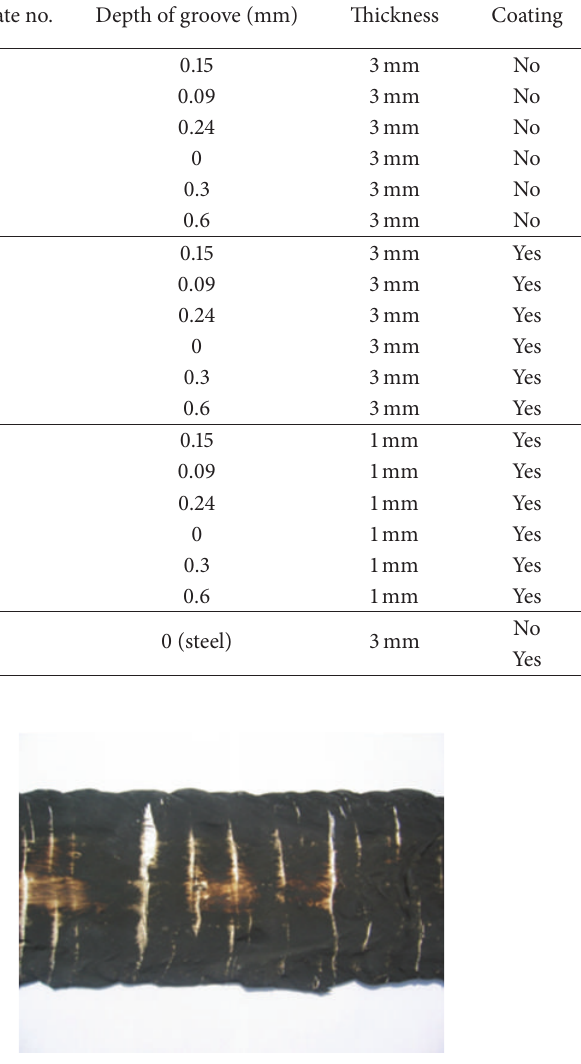
Figure 11: Black layer of coating on strip cast without protective atmosphere.